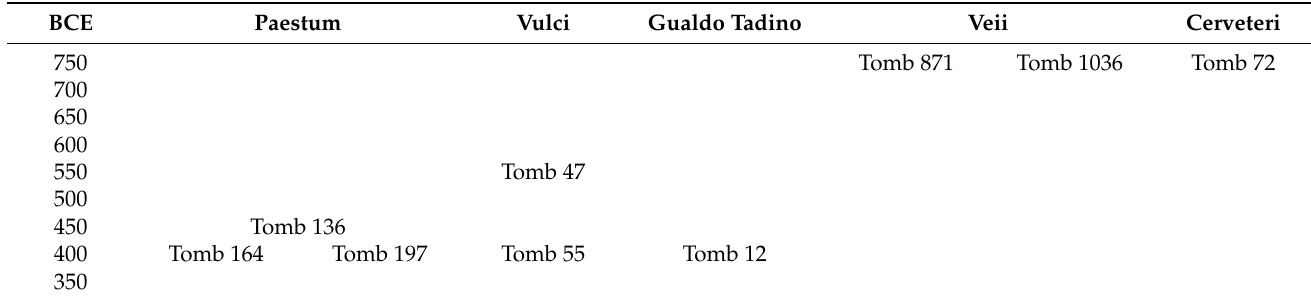
Table 2. Location and date of the different tomb assemblages examined here across